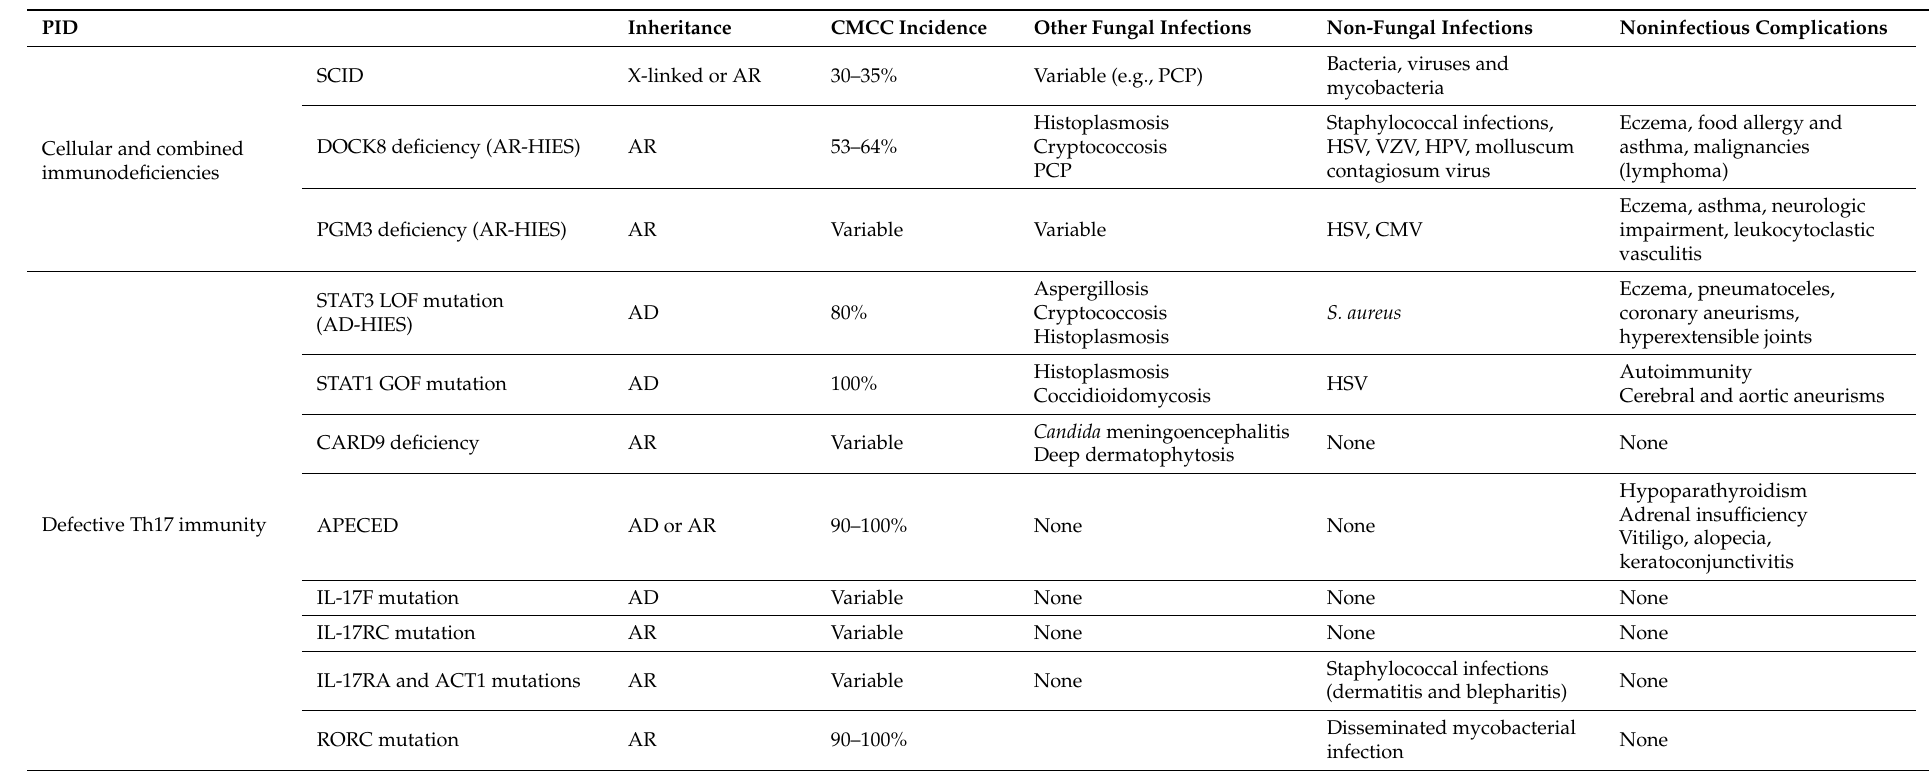
Table 3. Primary Immunodeficiencies (PID) associated with chronic mucocutaneous candidiasis (adapted from